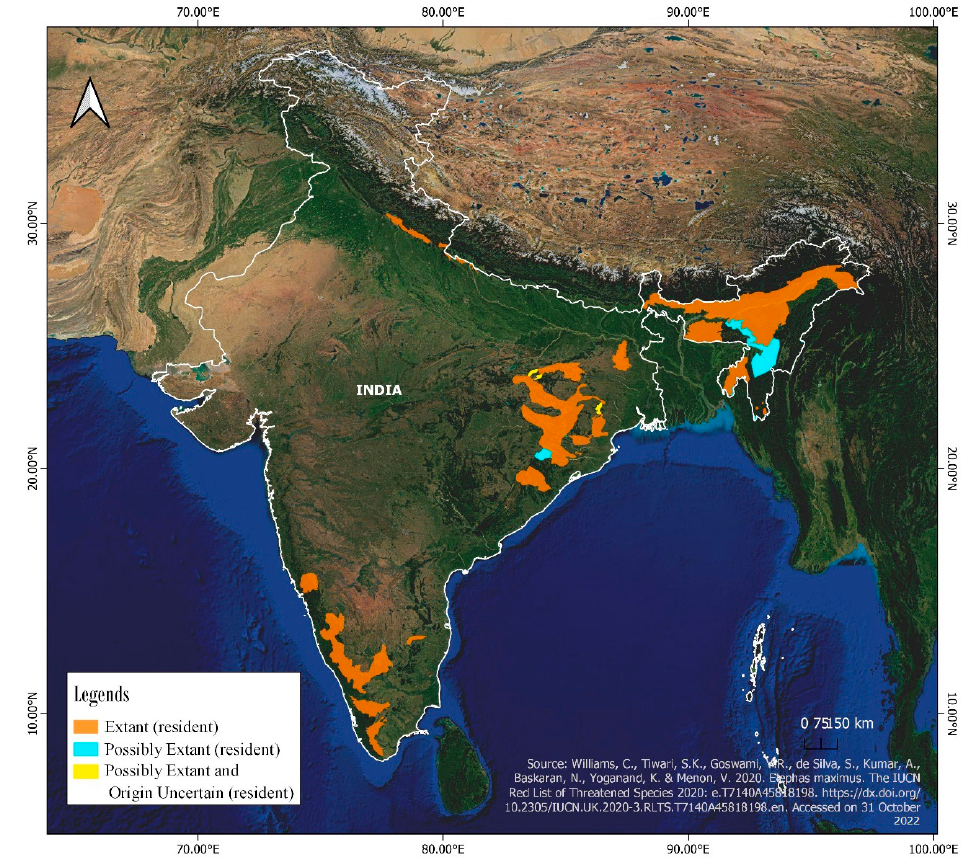
Figure 2. Distribution map of Elephas maximus : The map illustrates extant ranges of Asian Elephants [3] .